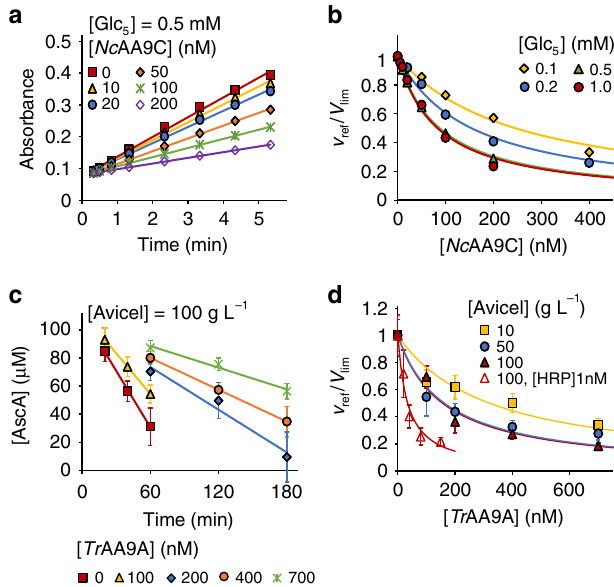
Fig. 5 Inhibition of HRP by Nc AA9C/Glc 5 and Tr AA9A/Avicel. All experiments were made in Bis – Tris buffer (50 mM, pH 6.1) at 25 °C and contained AscA (0.1 mM), HRP (5.0 nM), and glucose (10 mM). a Progress curves for the oxidation of AR (0.2 mM) (measured as a change in absorbance at 570 nm) in the presence of Nc AA9C at different concentrations. Reaction mixtures contained GO (0.15 g L − 1 ) and Glc 5 (0.5 mM); for progress curves for reactions with other [Glc 5 ], see Supplementary Fig. 9. Solid lines show linear regression of the data. The slopes of the lines correspond to the rate of the reference reaction ( v ref ). b Dependency of v ref / V lim on [ Nc AA9C] at different substrate concentrations. Solid lines show non-linear regression of the data according to Eq. (5). c Progress curves for the oxidation of ABTS (0.2 mM) (measured as consumption of AscA) in the presence of Tr AA9A at different concentrations. Reaction mixtures contained GO (0.035 g L − 1 ) and Avicel (100 g L − 1 ); for progress curves for reactions with other [Avicel], see Supplementary Fig. 12. Solid lines show linear regression of the data. The slopes of the lines correspond to the rate of the reference reaction ( v ref ). d Dependency of v ref / V lim on [ Tr AA9A] at different substrate concentrations. Note that in one series (opened red triangles) the [Avicel] was 100 g L − 1 but the [HRP] was 1.0 nM instead of the usual 5.0 nM. Solid lines show non-linear regression of the data according to Eq. (5). Data are presented as average values ( n = 2 for a and b , n = 3 for c and d , independent experiments) and error bars (in c and d ) show SD. Source data are provided as a Source Data fi